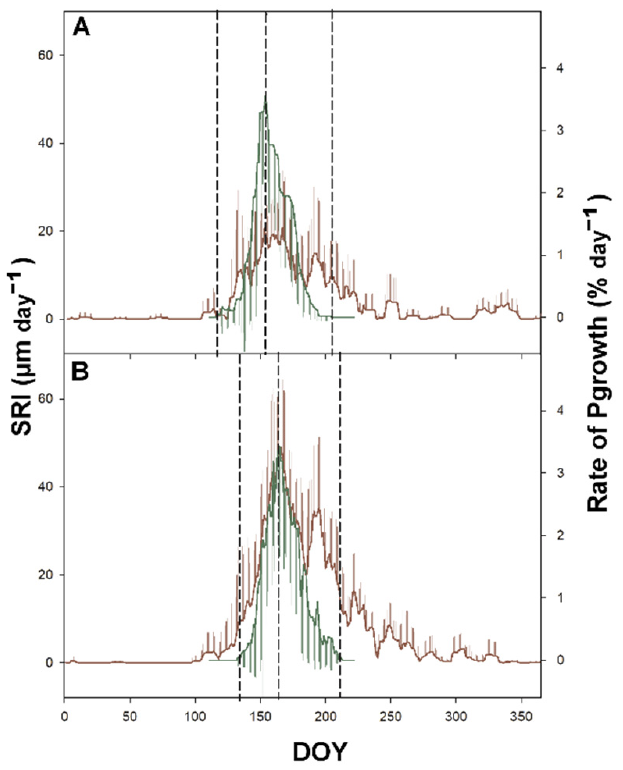
Figure 6. Mean value of daily rate of S growth (brown line; SRI) and P growth (green line; P growth ) calculated for all study years (2016–2019) at the ESP Rajec ( A ) and Bily Kriz ( B ). Vertical bars represent standard deviation.